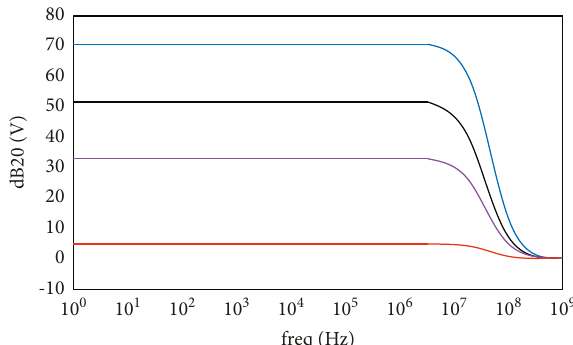
Figure 7: Gain-adjustable simulation